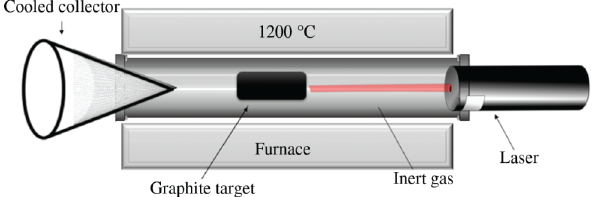
Figure 8: Example of experimental setup for the laser ablation technique with inert